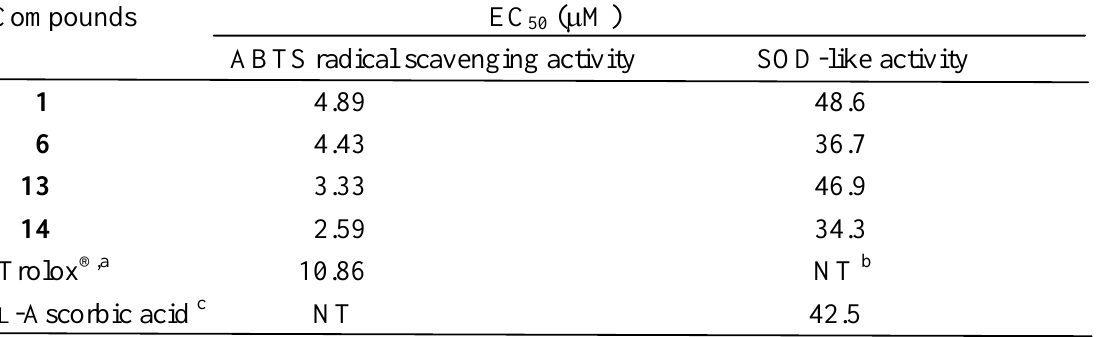
Table 2. ABTS radical scavenging activity and superoxide dismutase (SOD)-like activity of baicalein ( 1 ), 6-hydroxyapigenin ( 6 ), 6-hydroxygalangin ( 13 ) and 6-hydroxy- kaempferol ( 14